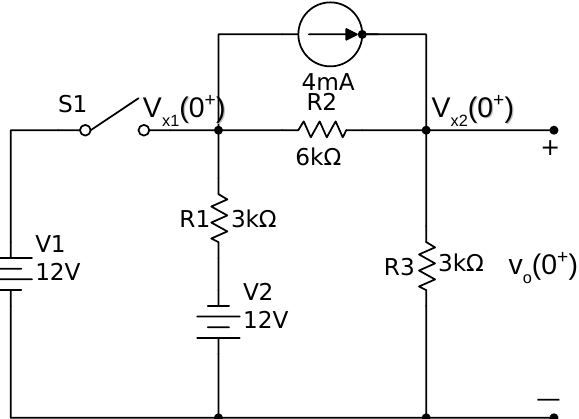
Figure 3. Circuit condition at t = 0 + immediately after the switch S 1 is opened. The inductor is replaced by a current source with a current equal to the initial current through the inductor.